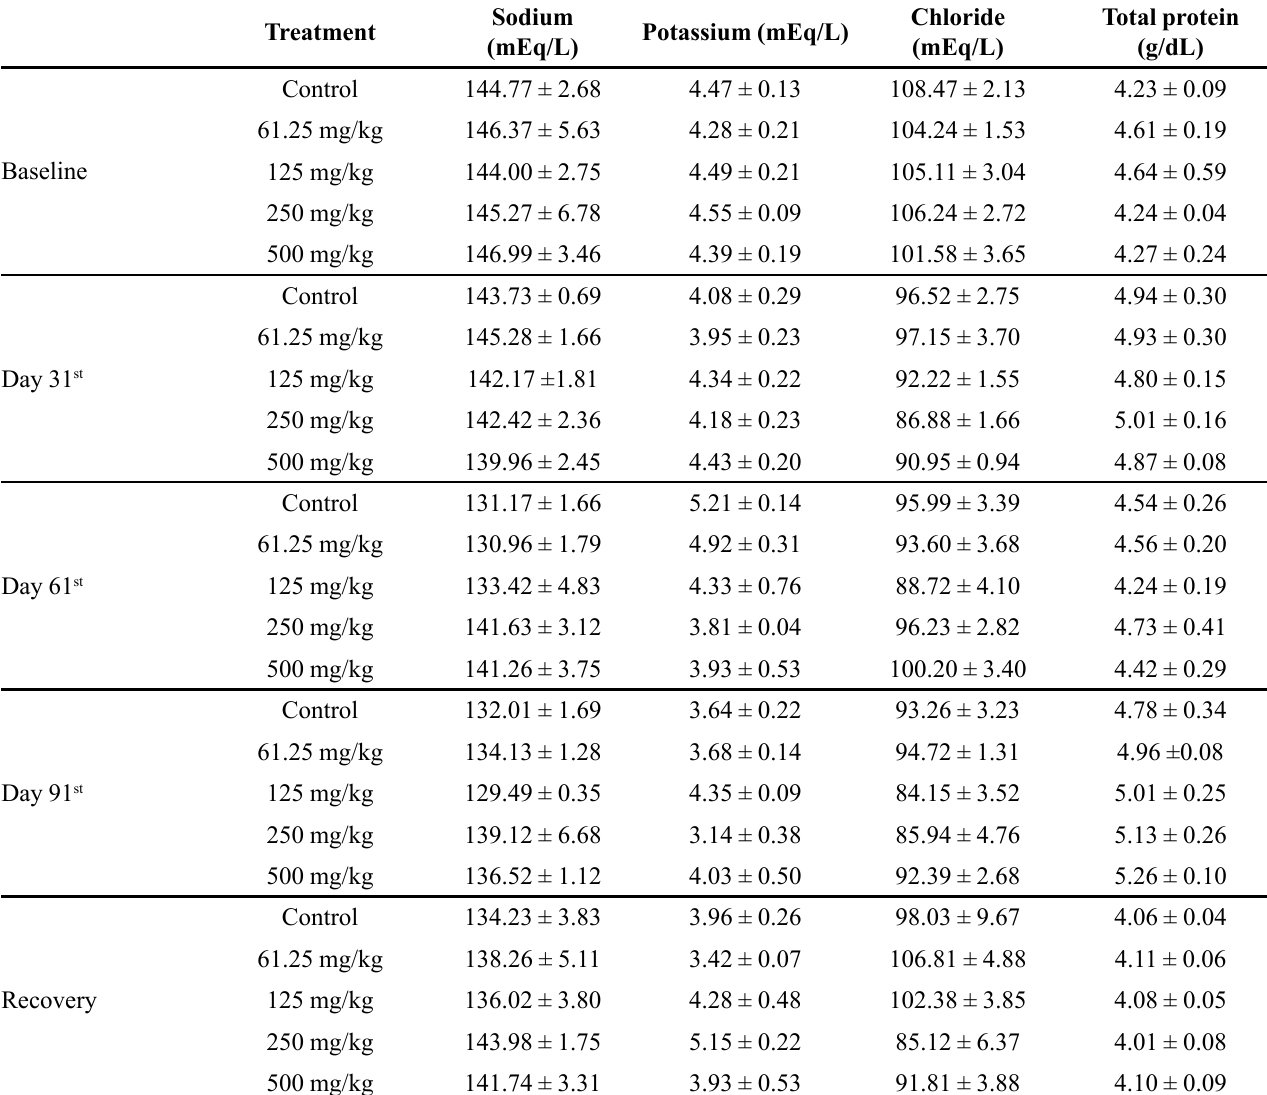
TABLE VII - Effect of sub-chronic administration of Dryopteris filix-mas ethanol leaf extract on sodium, potassium, chloride